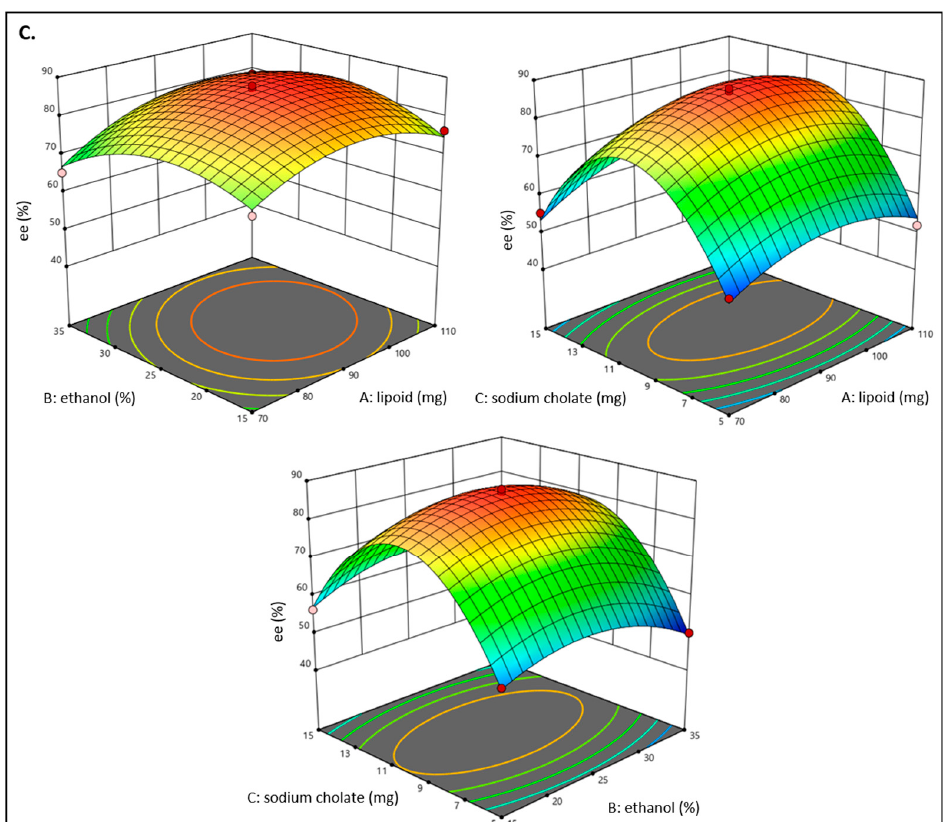
Figure 1. The fi gure shows the following: ( A ) 3D surface plot representation of the relationship between independent variables and vesicle size, ( B ) 3D surface plot representation of the relationship between independent variables and PDI, and ( C ) 3D surface plot representation of the relationship between independent variables and entrapment e ffi ciency %.